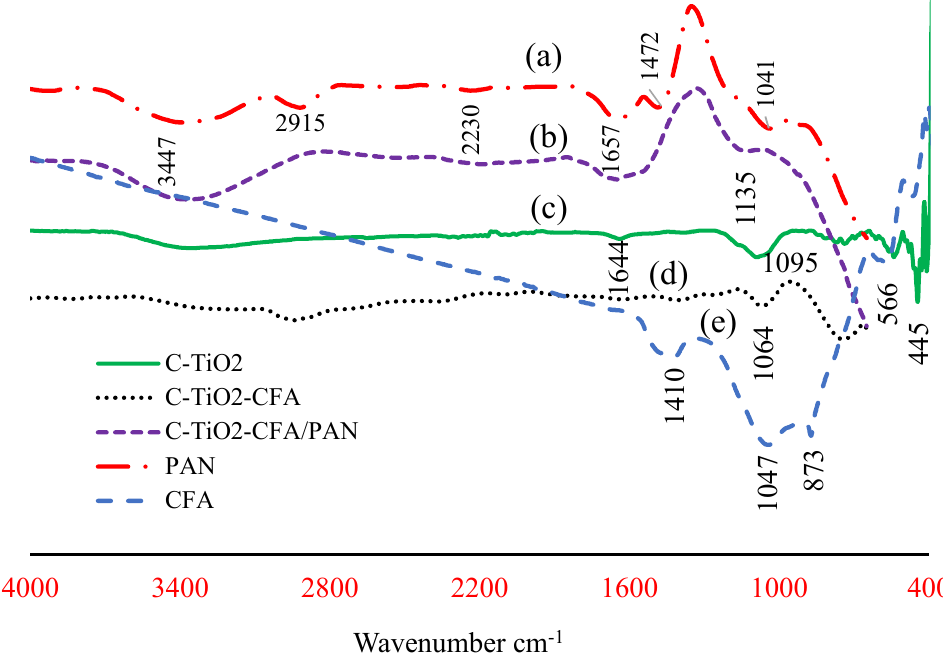
Figure 1. FTIR spectra of ( a ) PAN, ( b ) C-TiO 2 -CFA/PAN, ( c ) C-TiO 2 , ( d ) C-TiO 2 -CFA, and ( e ) CFA.